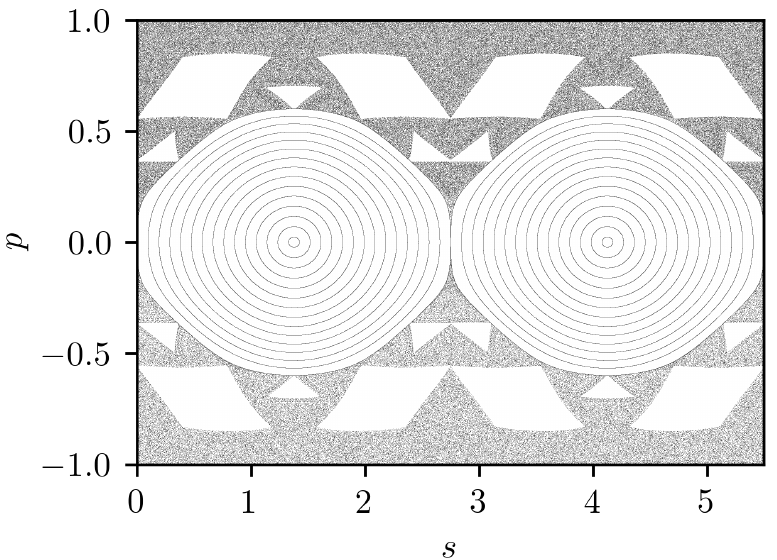
Figure 1. The phase portrait of the lemon billiard of B = 0.1953. The parameters are: the relative fraction of the area of the chaotic component of the bounce map, χ c = 0.3585, the relative fraction of the phase space volume, ρ 2 = 0.2804, and the complementary regular region, ρ 1 = 1 [ 0,5.4969 ] , and the ordinate is the momentim, p The abscissa is the location point, s ∈ the boundary at the collisions point. The chaotic component was created by a single chaotic orbit.